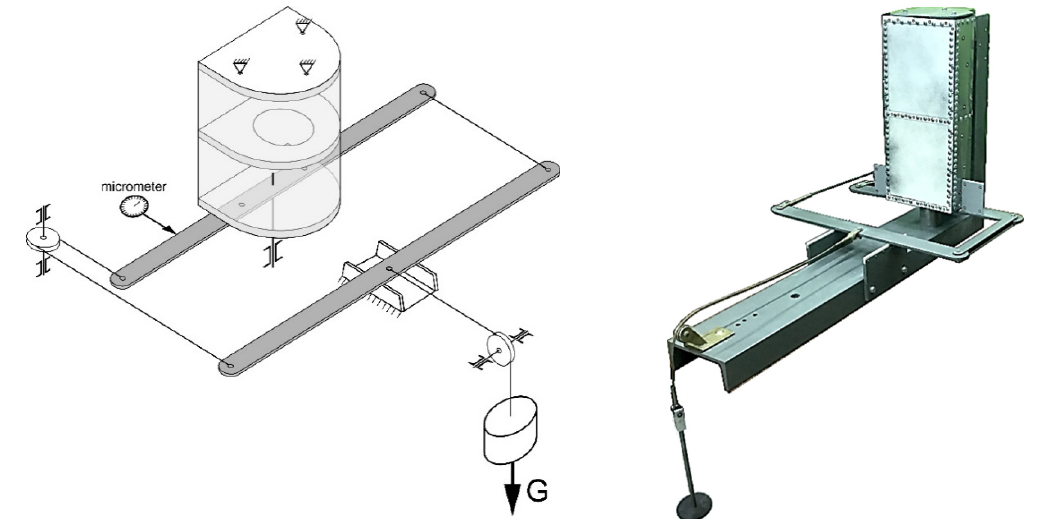
Figure 12. Model printout structure diagram.